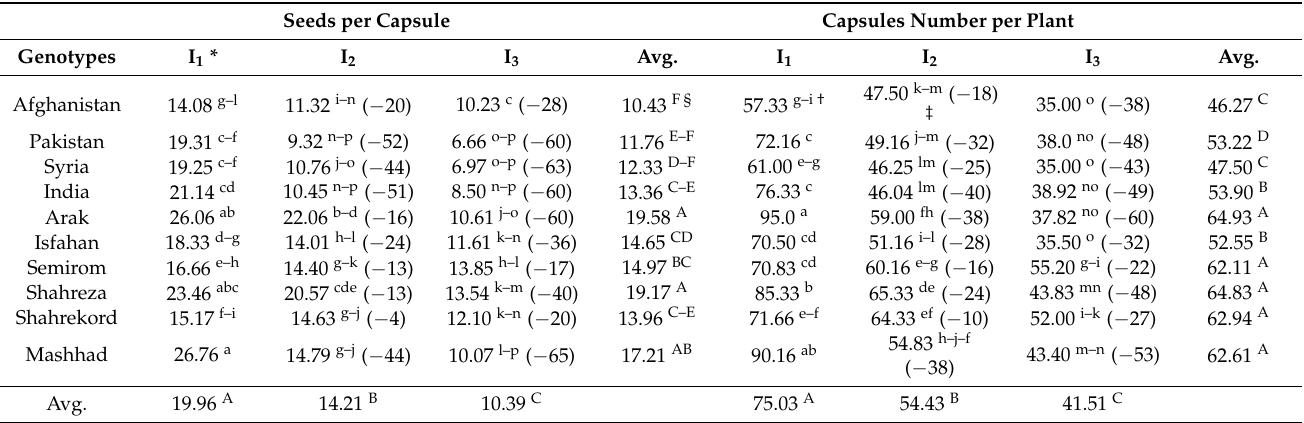
Table 10. Mean comparison of the effect of irrigation regime (I), genotype (G), and their interaction on capsules number per plant and seeds per capsule of black